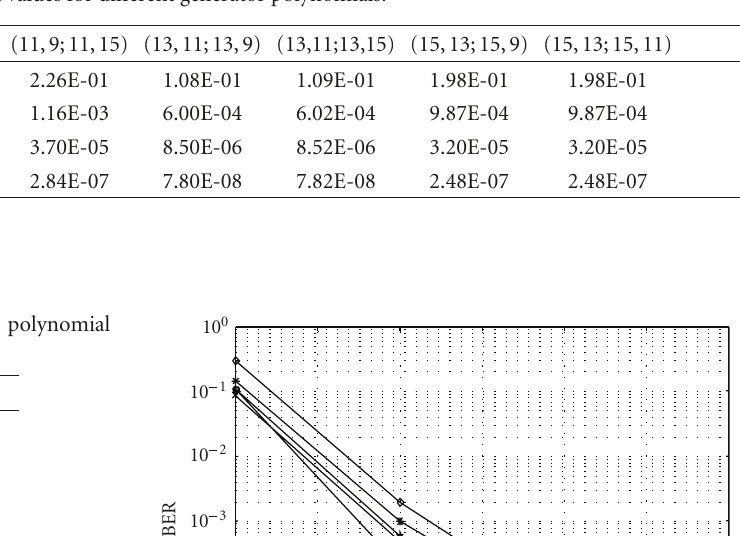
Table 1: BER values for di ff erent generator polynomials.